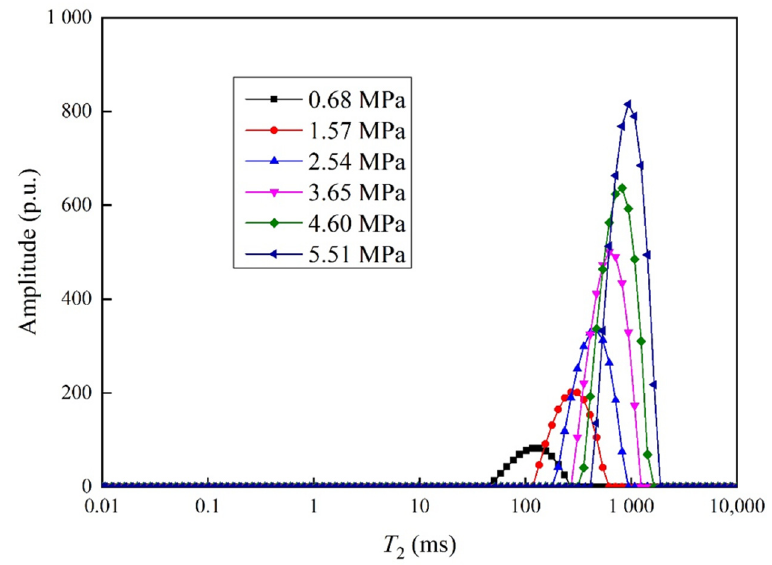
Figure 3. NMR T 2 distributions of free methane.